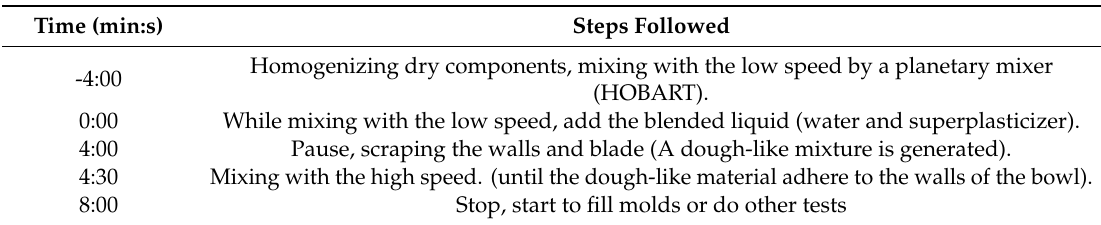
Table 4. Timeline and procedures of fresh mortar